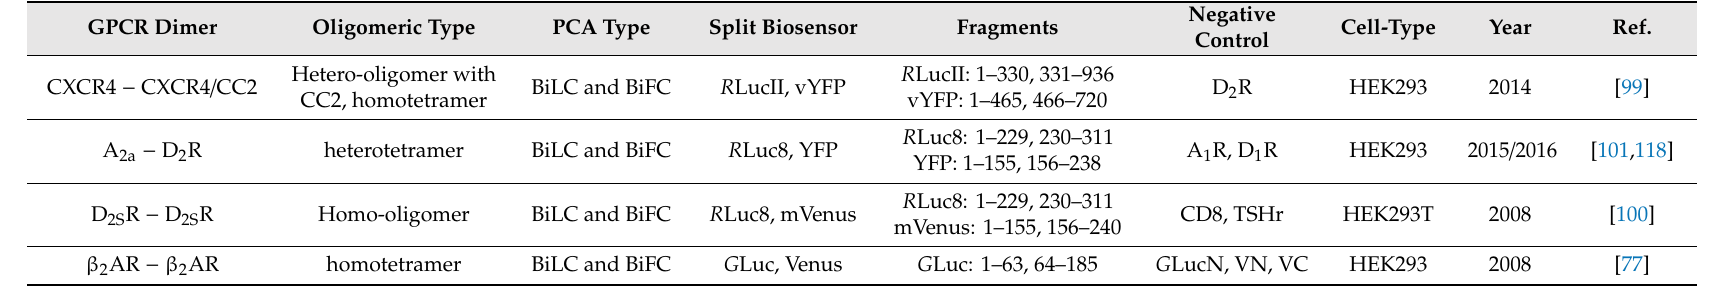
Table 2. Combinatorial assays with BiFC and BiLC for GPCR oligomerization